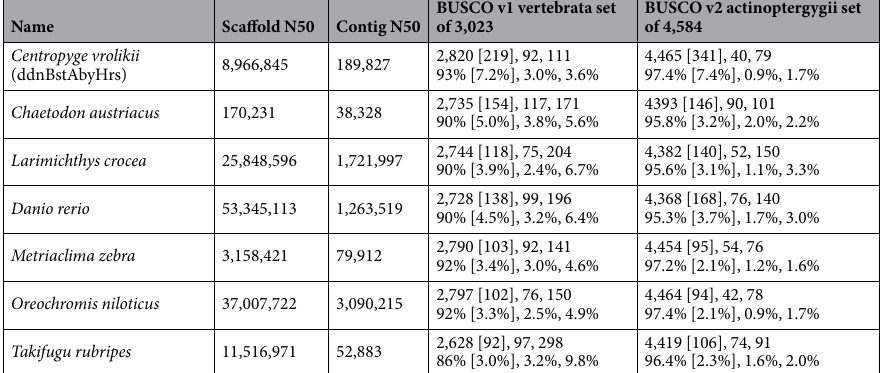
Table S1). The assemblies generated by ABySS 1.9 produced longer scaffolds, as measured by N50, than those gen- erated by BESST (Fig. 3 and Table S1). BESST generated more contigs greater than 1 M bp than ABySS (20 vs. 6). Scaffolding the BESST assembly with ABySS yielded the best results in terms of contiguity. A comparison of the candidate assemblies ddnBstAby and ddn, resulted in 3-, 21-, and 7-fold increases in contig N50, scaffold N50 and scaffold N90, respectively (Table S1). However, it was the application of the Chicago method and HiRise long-range scaffolding pipeline 8 that yielded the most dramatic increase in contiguity. For example, after the HiRise scaffolding, the scaffold N50 increased by 89.9-fold from ddn to ddnHrs and by 5.6-fold when comparing ddnBstAby to ddnBstAbyHrs. As expected from a long-range scaffolding method, the improvement on contig length (e.g. contig N50 and L50) was negligible in pre-HiRise and post-HiRise comparisons. Similarly, the CEGMA and BUSCO scores did not improve after HiRise (Fig. 3 and Table S1) likely due to the narrow margin for improvement given the high scores achieved in the pre-HiRise assemblies (95.9–96.3% BUSCO scores). To compare our assembly to previously pub- lished genomes that did not use BUSCO, we calculated both BUSCO and CEGMA scores. We used BUSCO v1 (vertebrata set) to compare previously published genomes that used the vertebrata set and BUSCO v2 with the fish specific Actinopterygii set for future comparisons (Table 2). Based on highest scaffold N50/L50 scores, longest contig and scaffold lengths, and best CEGMA scores (Table S1), we chose the candidate assembly ddnBstAbyHrs for final annotation and future analyses. Although the pre-HiRise version (ddnBstAby) had a higher contig N50 than the post-HiRise version, possibly due to mis- assemblies corrected by the HiRise pipeline, it had a much lower scaffold N50. The quality of ddnBstAbyHrs was similar to ddnBstHrs, which had slightly better Scaffold N90/L90 values, more scaffolds longer than 1 Mbp, better BUSCO scores and a lower proportion of Ns (% of Ns). However, ddnBstAbyHrs is a good compromise between scaffold and contig N50. Henceforth, this assembly is referred to as C_vrolikii_CAS243847_v1.0, the first draft genome assembly of the Pearlscale Pygmy Angelfish.